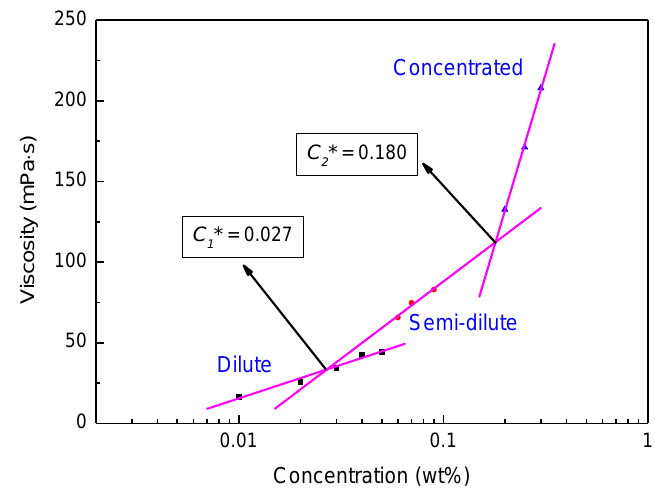
Figure 3. Determining C 1* and C 2* for HELV.